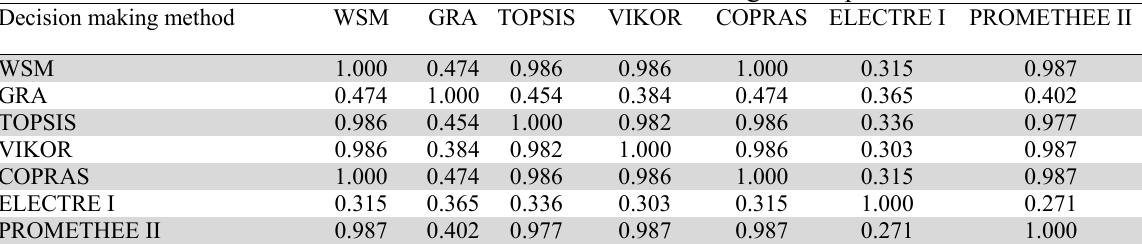
Correlation matrix between each two multi-criteria decision making techniques Decision making method